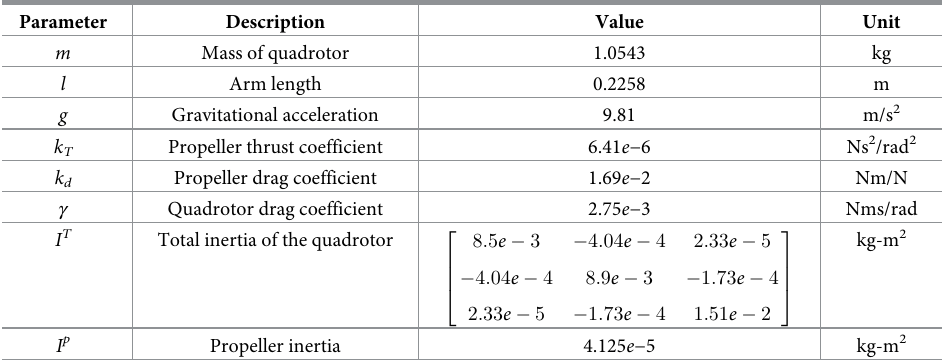
Table 2. Parameters of the quadrotor.